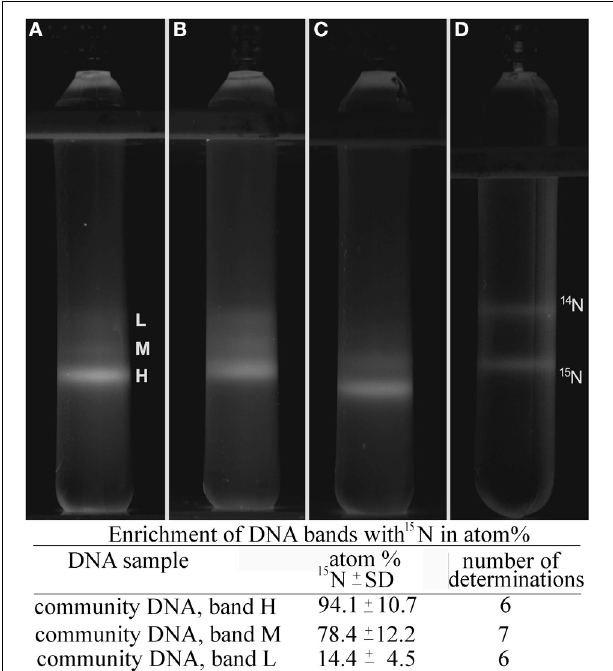
FIGURE 2 | Isopycnic centrifugation of 15 N labeled community DNA in CsCl/ethidium bromide density gradients. Centrifuge tubes were exposed to a UV transilluminator and photographed. (A–C) DNA extracted from microcosm made with FG medium (A) , Wuchter medium (B) , or Simon medium (C) , respectively, inoculated with planctonic microorganisms (A,C) or biofilm material (B) . Incubation temperature was 40 ◦ C for all microcosms. (D) A mixture of labeled ( 15 N) and unlabeled ( 14 N) DNA, extracted from Nitrosomonas europaea . L, M, H in (A) indicate the positions of light, medium, and heavy DNA bands, respectively. The enrichment of DNA bands with 15 N in atom %, as determined by isotope ratio mass spectrometry (IRMS), is